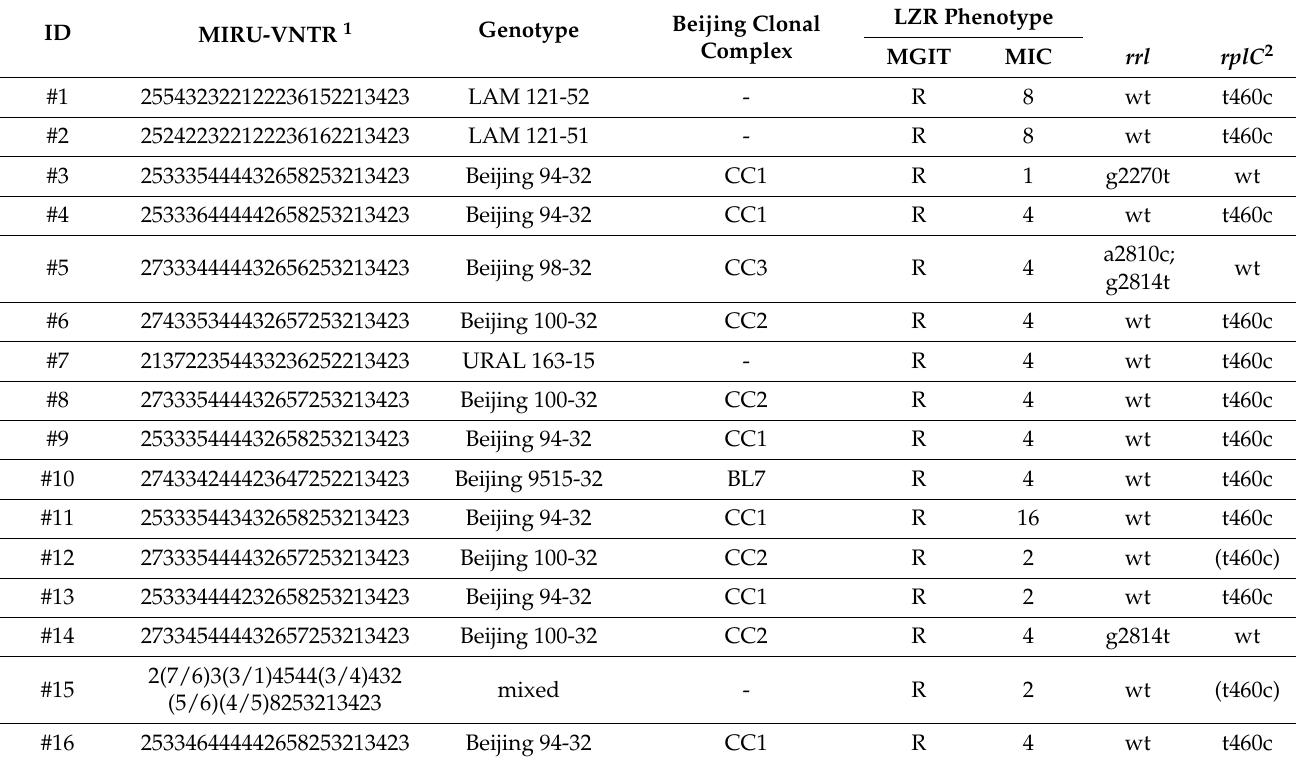
Table 1. Phenotypic and genetic characterization of the